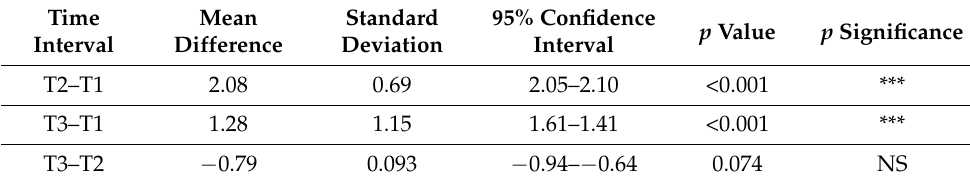
Table 4. Results of the mean differences (mm) of Nasal Width 2 in the three time intervals.